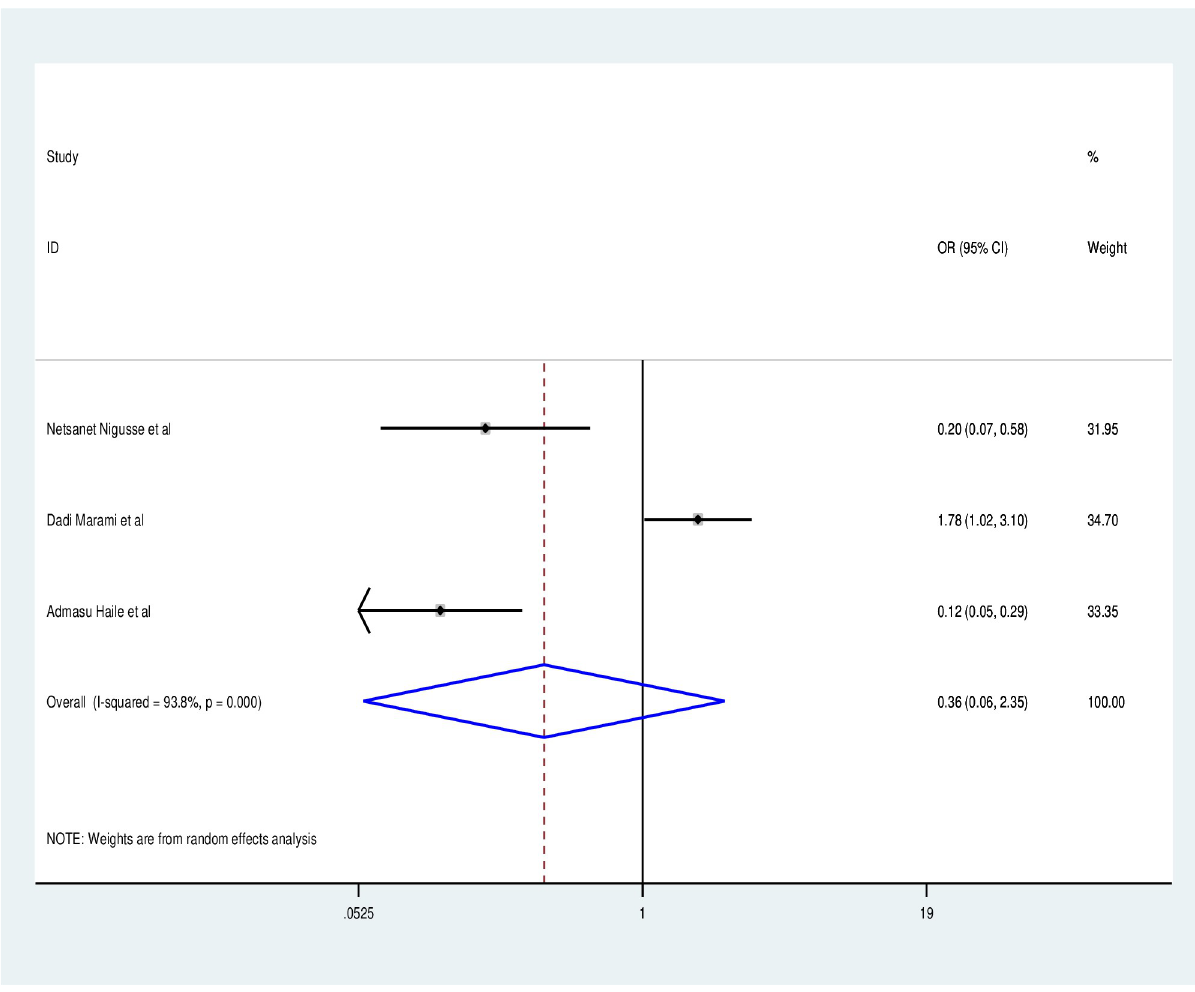
Fig 10. Factor analysis over diabetes